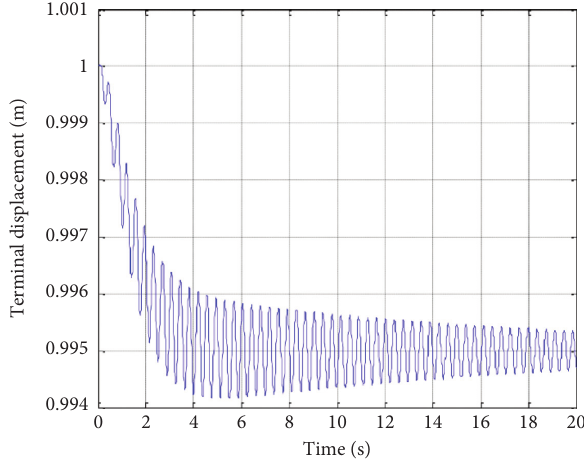
Figure 6: Tip displacement p